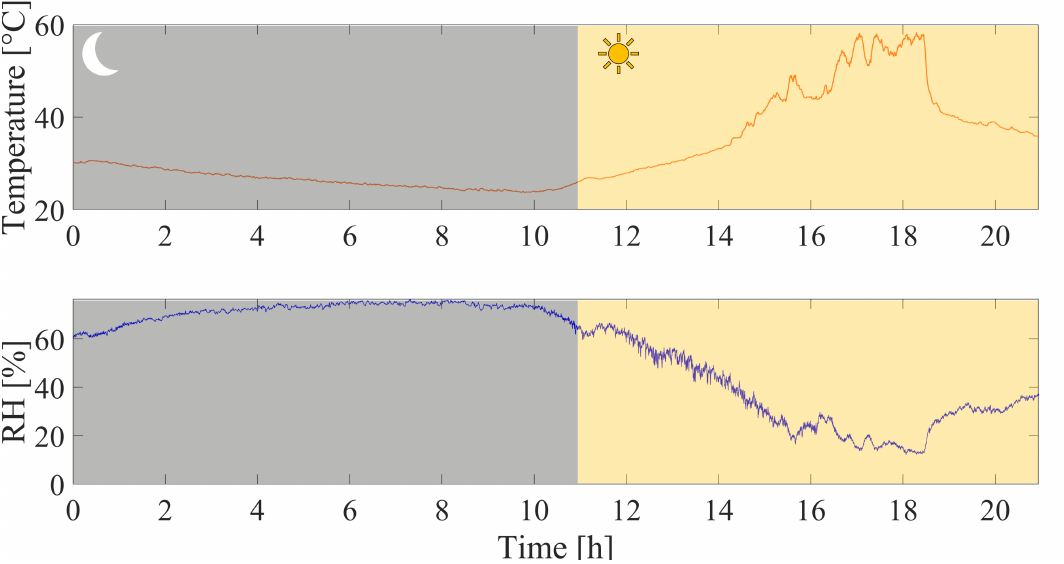
Figure 13. T ( top plot ) and RH ( bottom plot ) changes during the experimental trial performed on a melon in an open